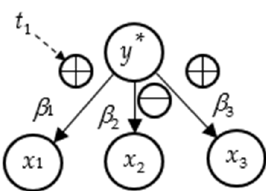
Figure 2. The task with coefficients of relative importance and directions of the changes in argu- ments.